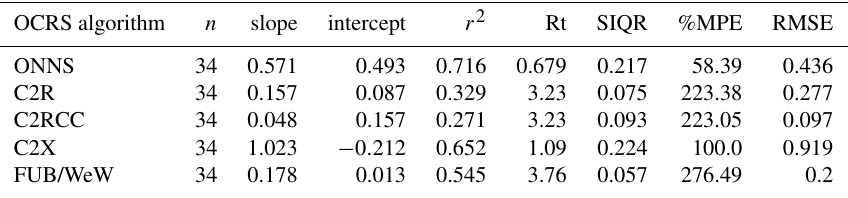
Table 3. Performance of tested OCRS algorithms for a CDOM (λ) sat with in situ a CDOM (443) or a CDOM (440). Note that not all OCRS algorithms are developed for the highly absorbing waters (high a CDOM (λ) ) found in the Arctic coastal